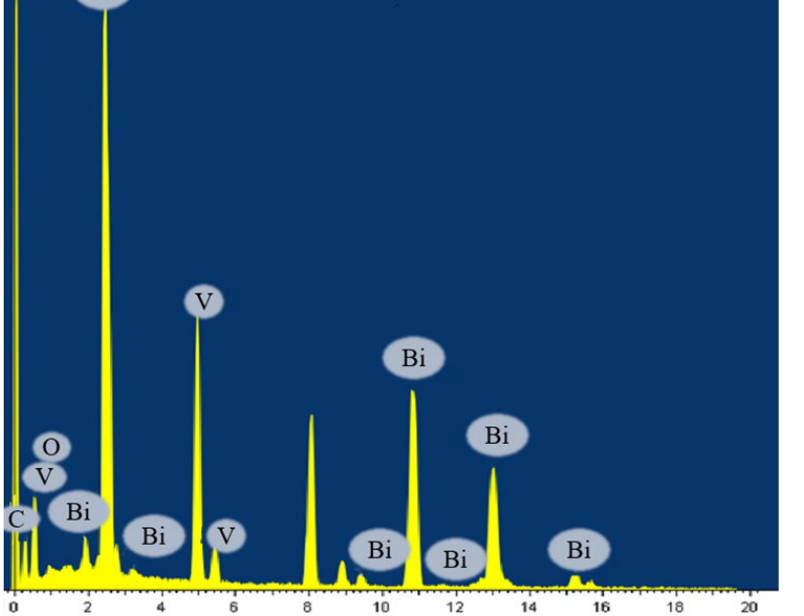
Figure 3. TEM images of the as-prepared photocatalysts. ( a ) HR-TEM image of pure BiVO 4 ; ( b ) HR- TEM image of 7 wt% graphene/BiVO 4 ; ( c ) low-resolution TEM image; ( d ) HR-TEM image TAgNPt/graphene/BiVO 4 with 0.003 wt% TAgNPts and 7 wt% graphene.